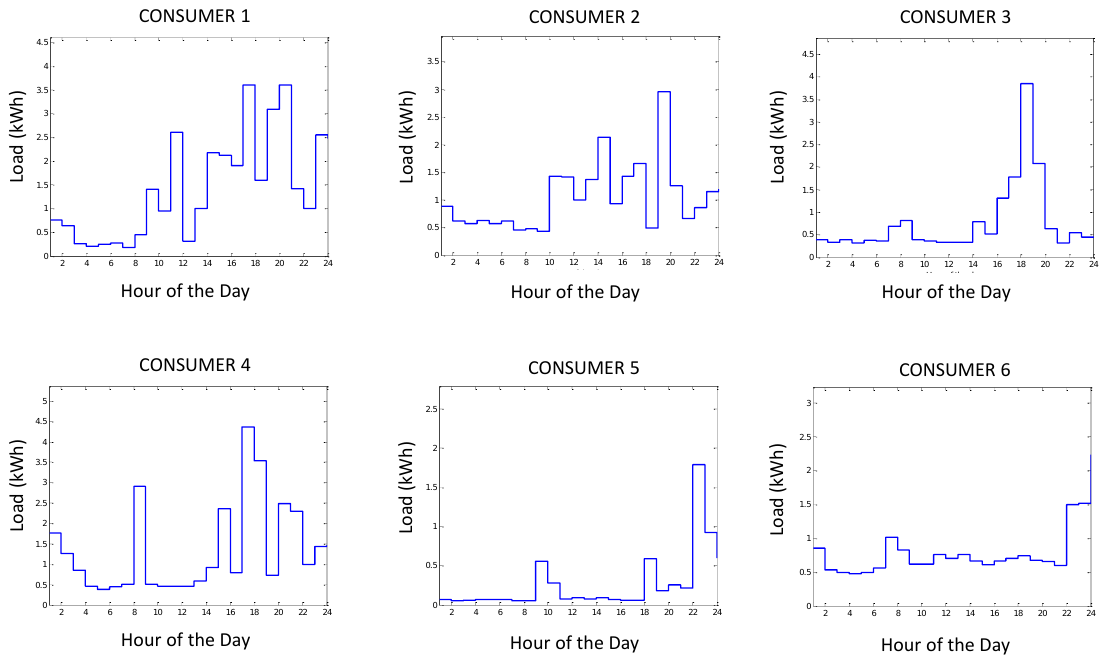
Figure 5. Anticipated load patterns of Consumers 1–6 for test Scenario 1.